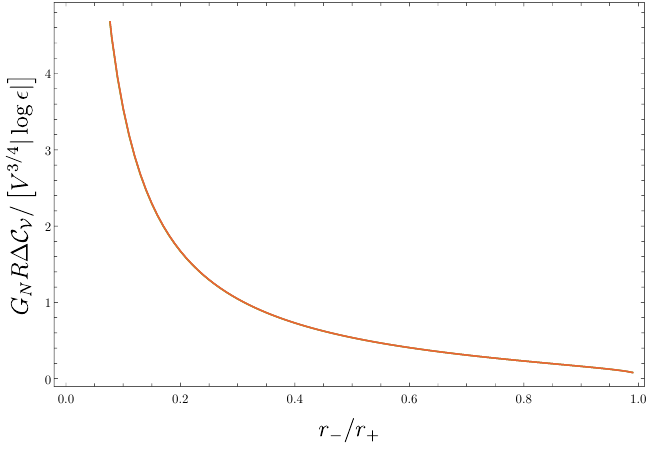
Figure 19. A plot of ∆ C V normalized by the thermodynamic volume to the appropriate power in five dimensions. The graph displays four curves corresponding to r + /‘ = 10 5 , 10 6 , 10 7 , 10 8 , the same as those shown in figure 17, but these curves cannot be distinguished from one another here. The curves are plotted as a function of (cid:15) = 1 − r − /r + . The value of r + /‘ increases from the blue curve to the red